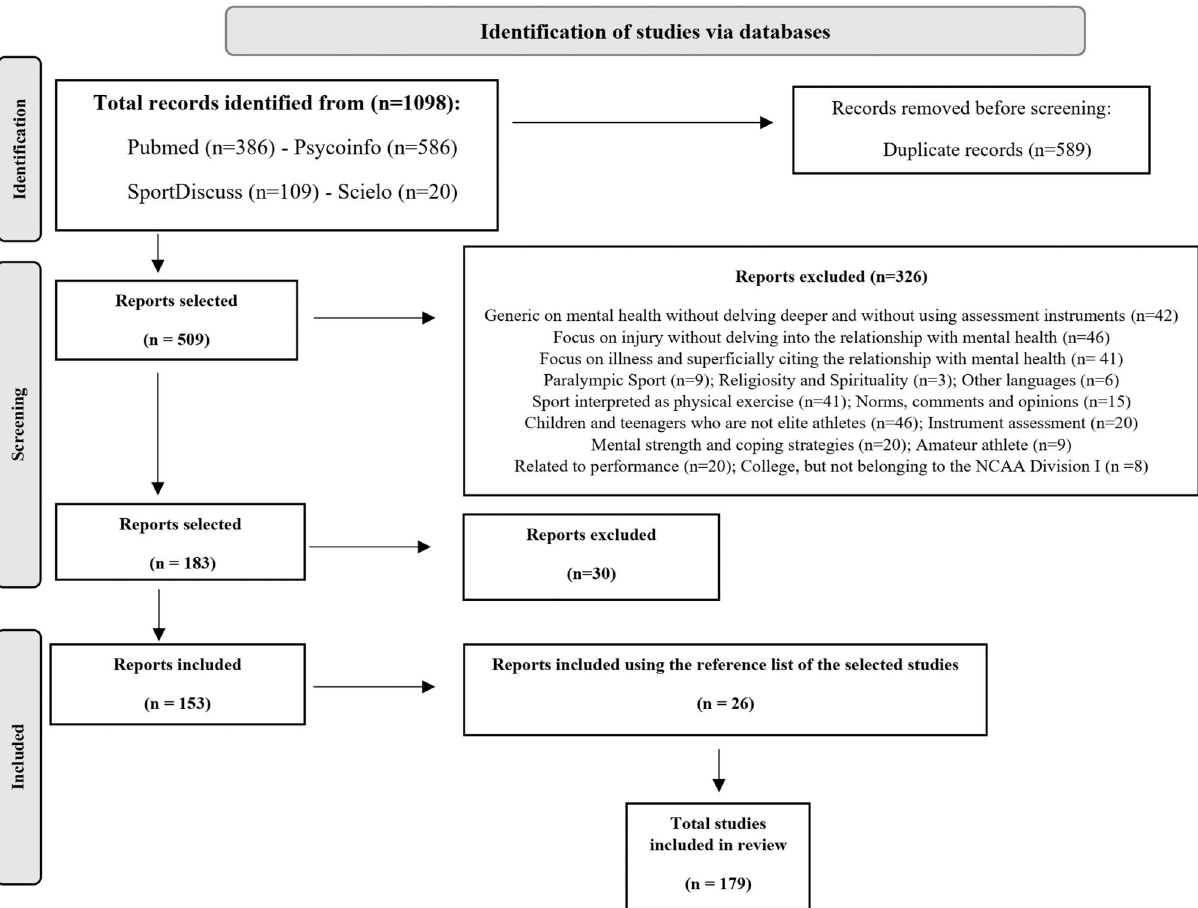
Figure 1 - PRISMA flowchart regarding the accomplishment of